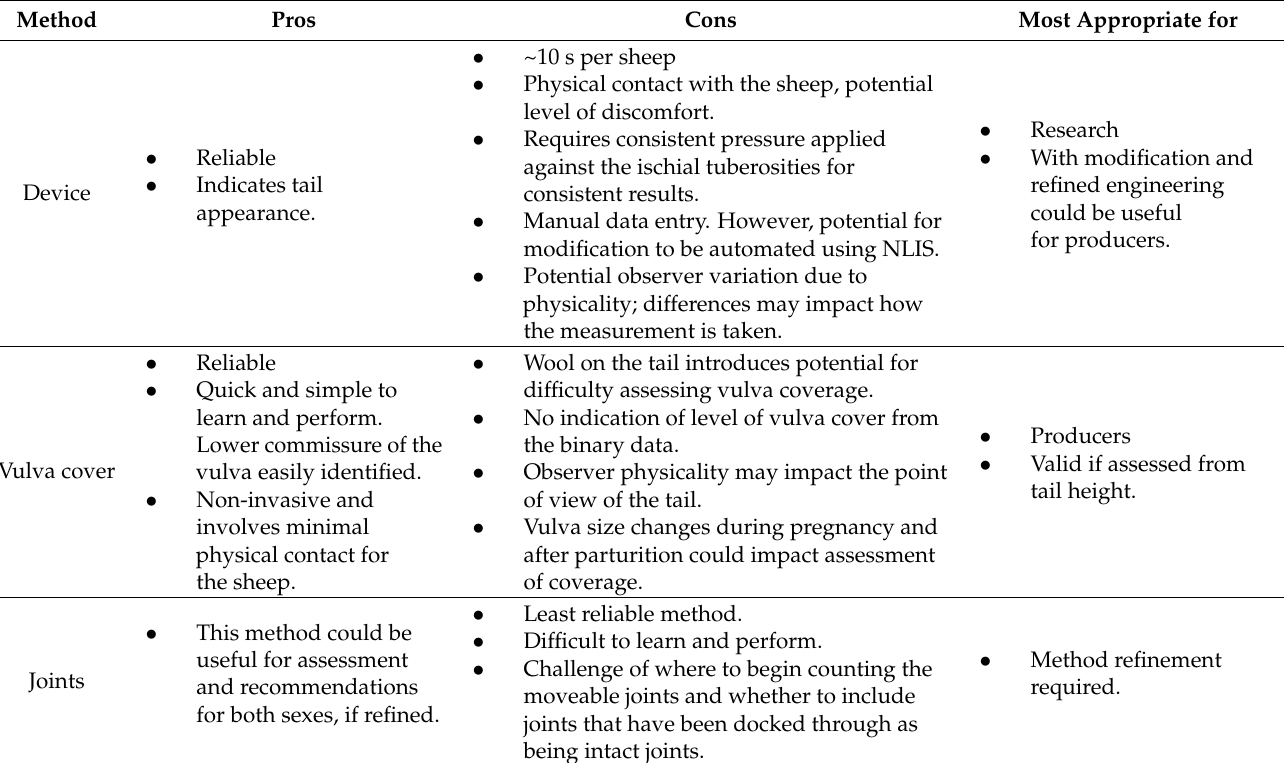
Table 6. Identified pros and cons of each tail length measurement method used in this